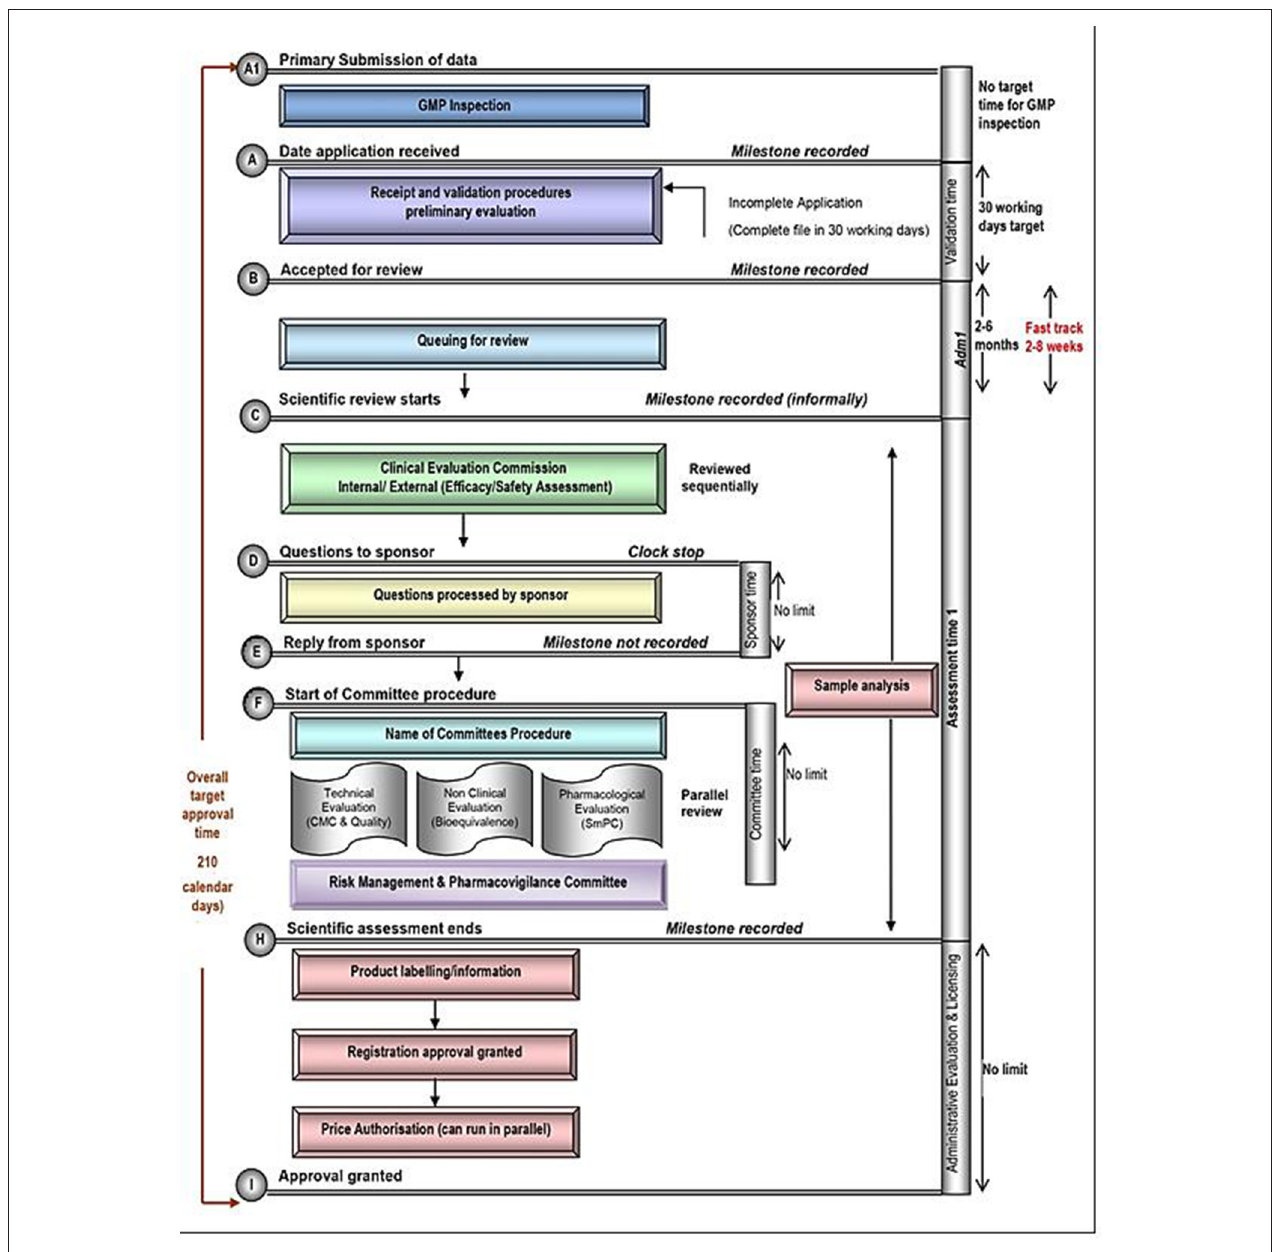
FIGURE 1 | Registration process map for